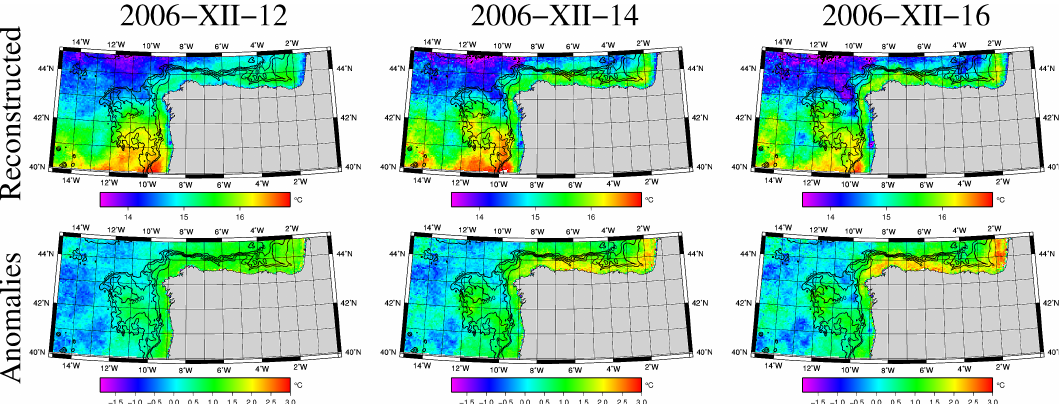
Fig. 5. Reconstructed SST fields (top panels) and their related anomalies (bottom panels) for 12, 14 and 16 December 2006.